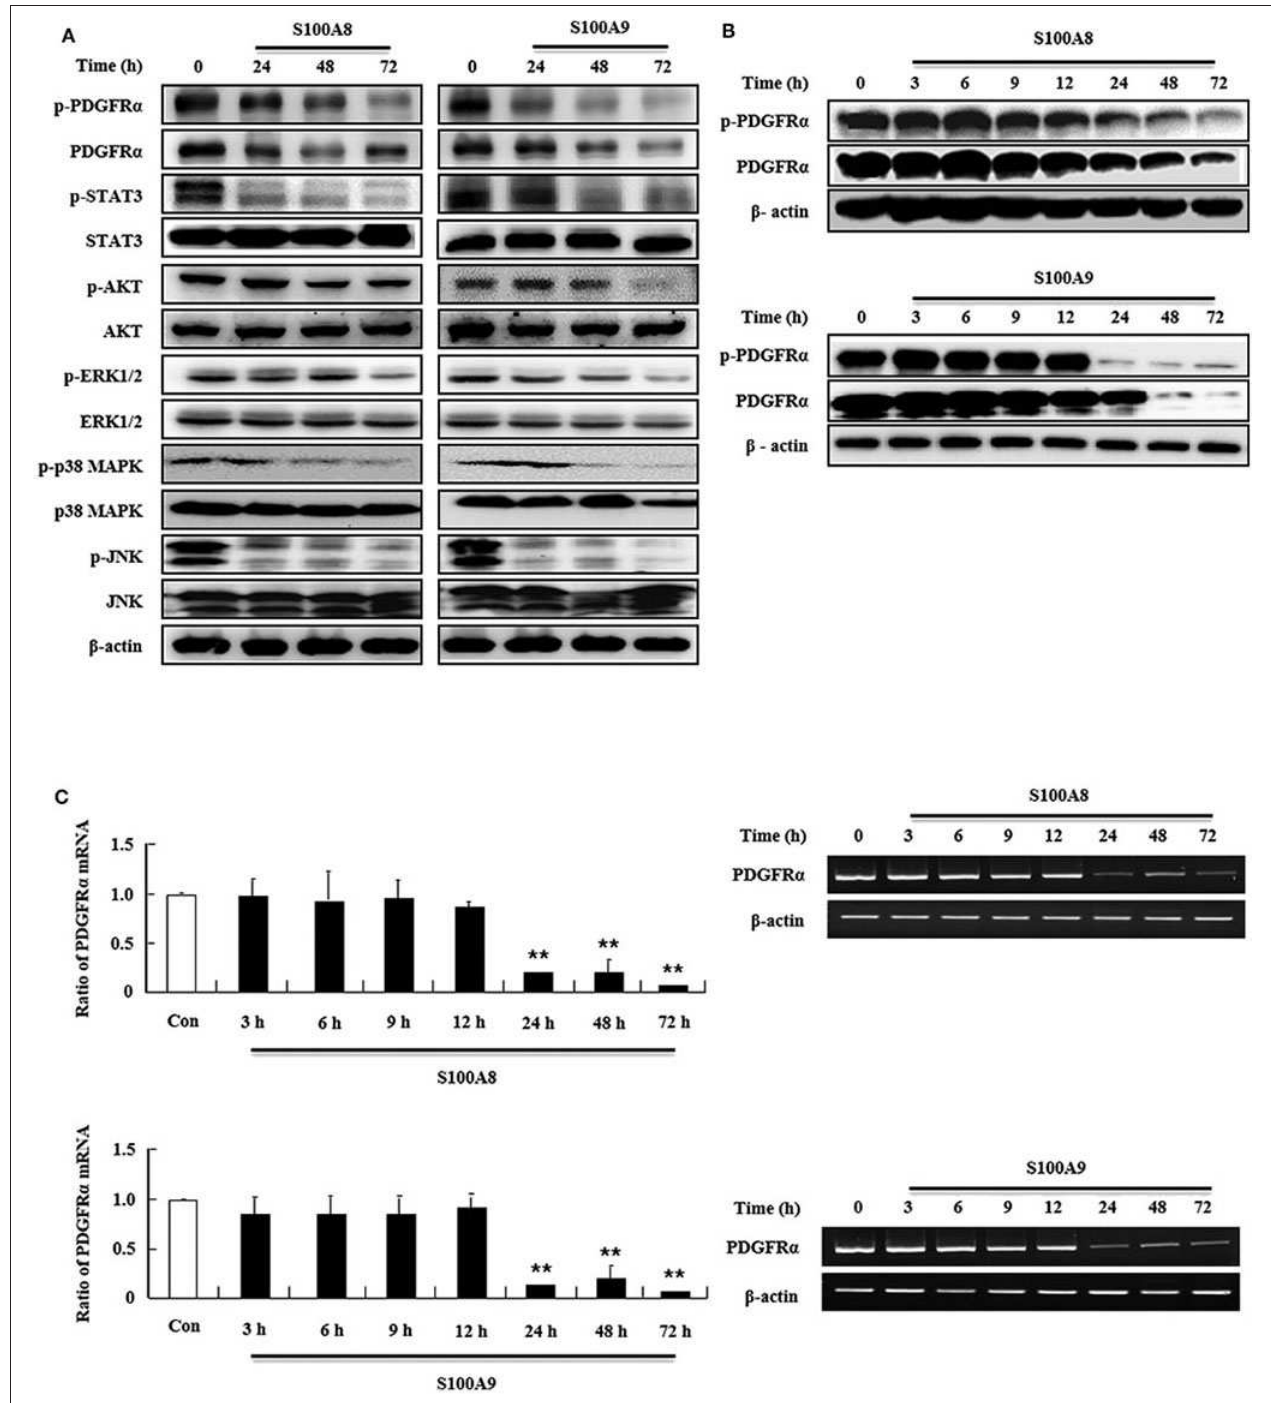
FIGURE 2 | S100A8 and S100A9 suppress downstream signal of FIP1L1-PDGFR α by decreasing its expression. (A) EoL-1 cells were incubated with S100A8 and S100A9 (10 µ g/mL) for 24, 48, and 72h. After cell lysis, phosphorylation and non-phosphorylation of PDGFR α , STAT3, AKT, ERK1/2, p38 MAPK, and JNK were detected in the lysates by applying Western blotting. (B,C) EoL-1 cells were incubated with S100A8 and S100A9 (10 µ g/mL) for the indicated time. After cell lysis, lysates were collected for detecting phosphorylation and non-phosphorylation of PDGFR α using Western blotting (B) . Total RNAs from EoL-1 cells were collected, and RT-PCR was conducted for detection of PDGFR α (C) . β -actin was used as an internal control. ** p < 0.01 indicates a significant difference between the control and stimulator-treated groups.